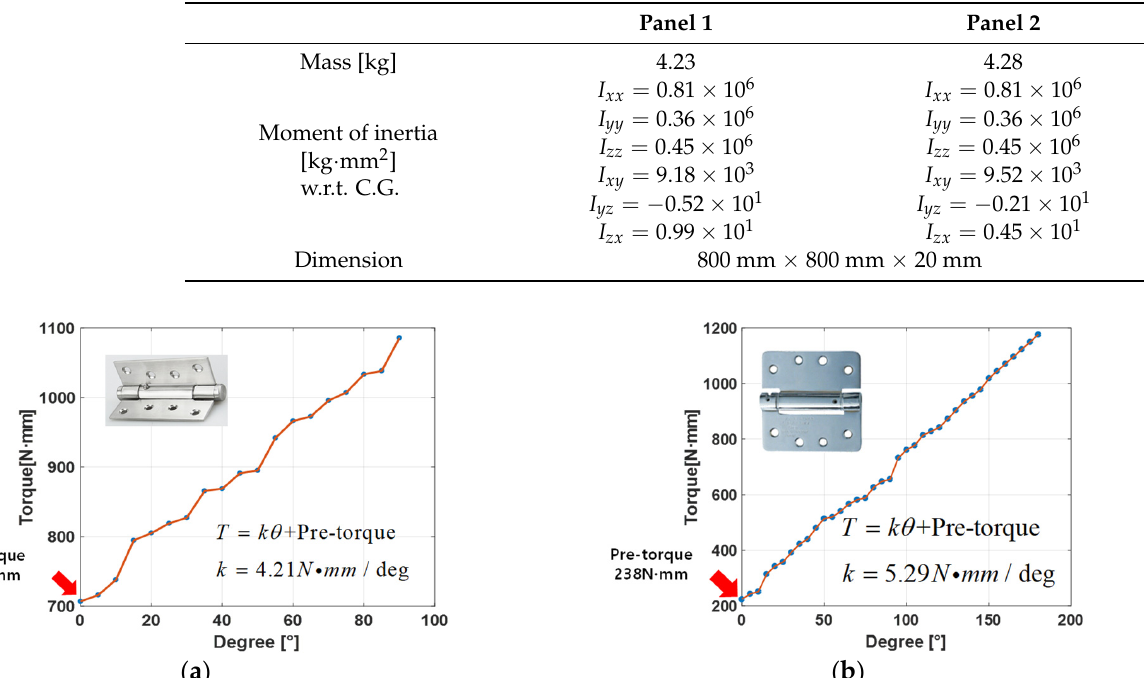
Table 7. Dimensions and mass properties of inner and outer panels. Panel 1 Panel 2